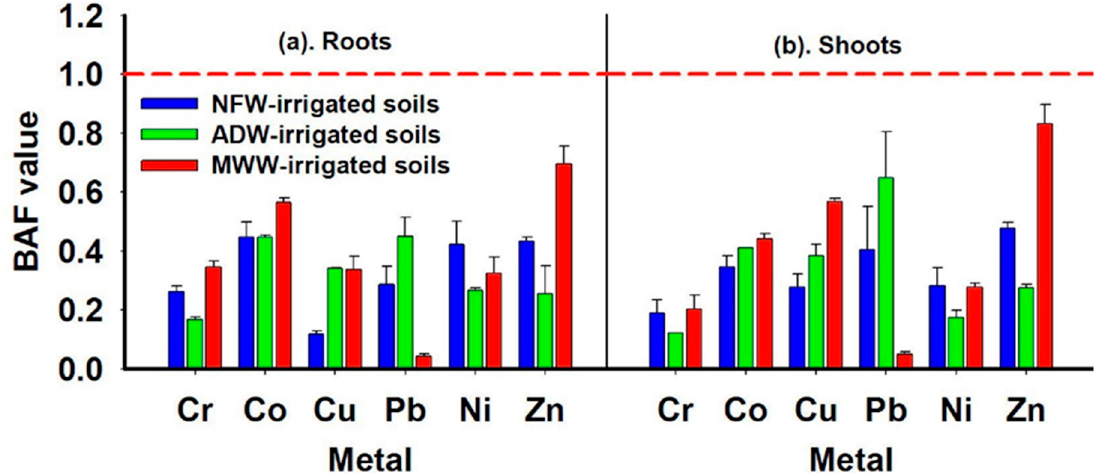
Figure 5. HM Bioaccumulation factor (BAC) of PTMs in berseem roots ( a ) and shoots ( b ).